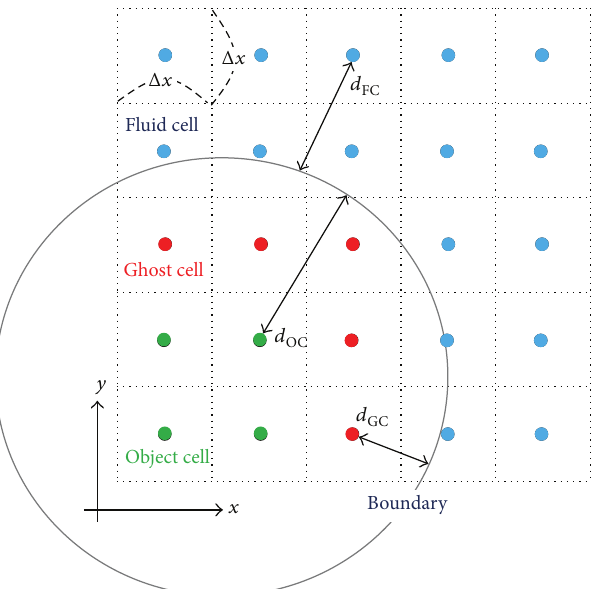
Figure 2: Cell construction and classification in the present level set method.